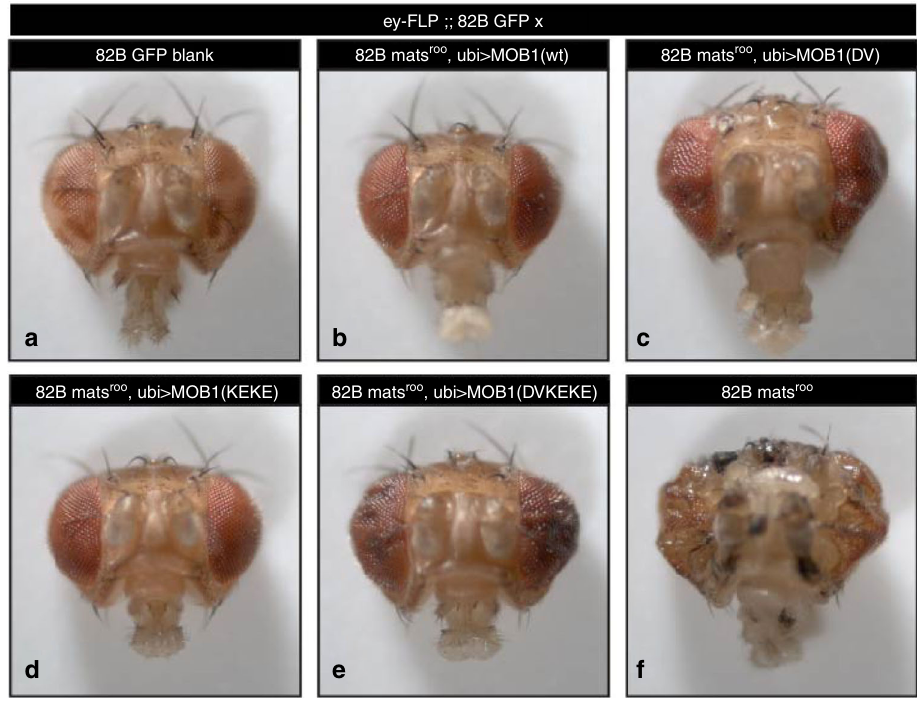
Fig. 5 Expression of MOB1(wt) or MOB1(K104E/K105E), but not MOB1(D63V) or MOB1(D63V/K104E/K105E), fully suppresses the mats eye overgrowth phenotype. Shown are frontal views of eyes from female progeny of the indicated genotypes ( wt , wild-type; DV D63V, KEKE K104E/K105E, DVKEKE D63V/K104E/K105E). A wild-type control eye is shown for comparison a . Expression of MOB1(wt) b or MOB1(K104E/K105E) d fully suppress the severe tissue overgrowth upon eyeless-FLP ( ey-FLP ) mediated formation of mats mutant clones in the eye (compare b , d with a and f ). Expression of MOB1(D63V) c or MOB1(D63V/K104E/K105E) e does not fully suppress eye overgrowth upon mats loss-of-function (compare c , e with a and f